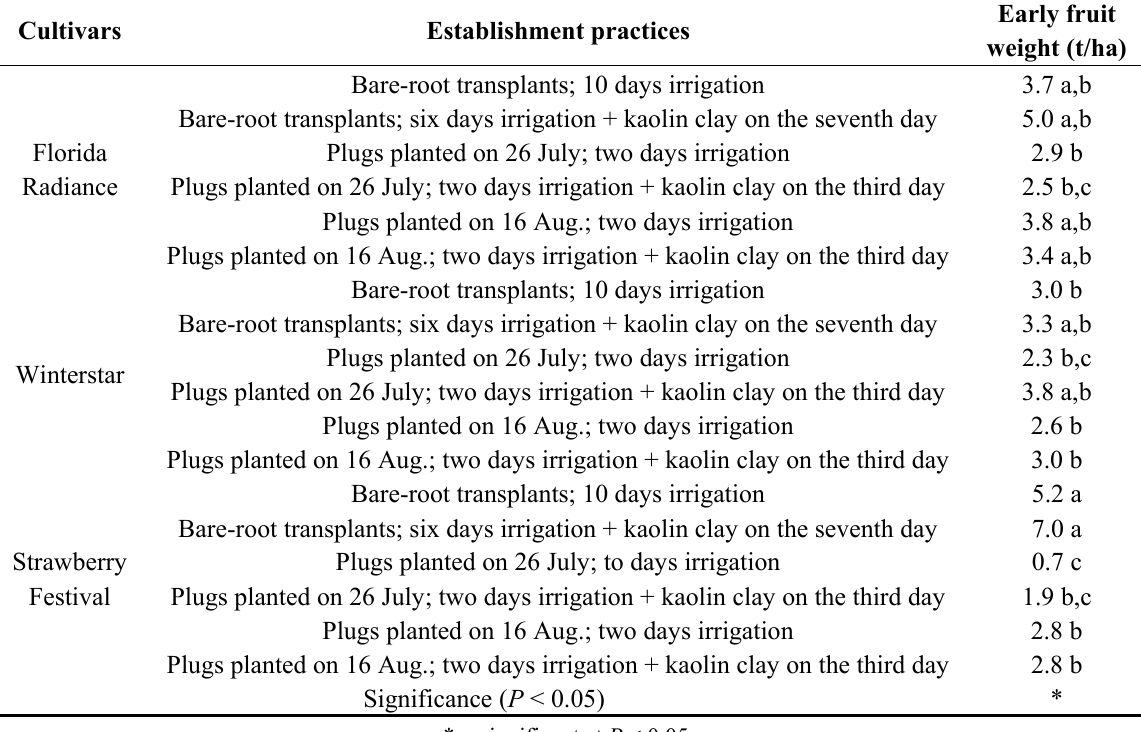
Table 1. Early fruit weight of strawberry cultivars from different transplant types and establishment practices in Balm, FL, USA, during the 2010–2011 season. Cultivars were “Florida Radiance”, “Winterstar TM ” and “Strawberry Festival”. Transplant types were bare-root and containerized (plug) plants, and establishment practices were 10 days of sprinkler irrigation, six days of sprinkler irrigation plus kaolin clay on the seventh day, two days of sprinkler irrigation and two days of sprinkler irrigation plus kaolin clay on the third day. Treatment means followed by the same letter do not differ at the 5% significance level according to Fisher’s-protected least significance difference test.